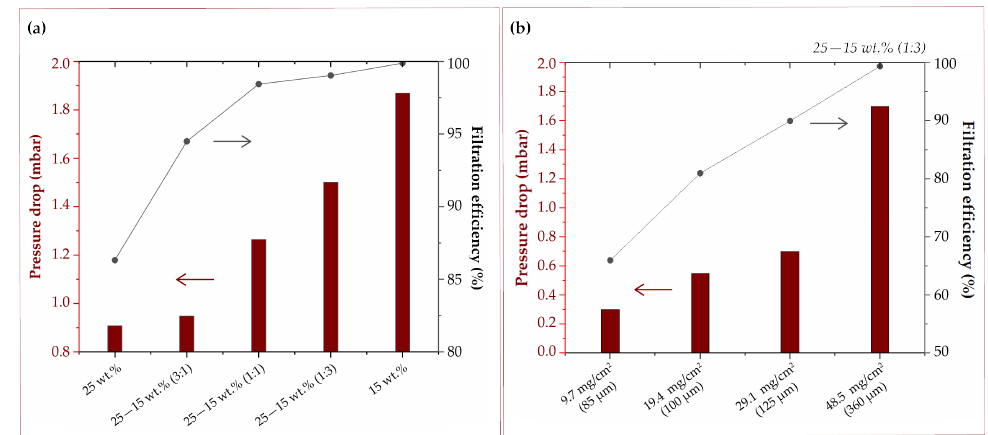
Figure 6. ( a ) Filtering efficiency against submicronic particles (0.01–1.0 µ m) and pressure drop against different combinations of fiber diameters obtained by electrospinning solutions of 15 and 25 wt.% PET at different ratios and ( b ) solutions of 15–25 wt.% PET (3:1) at different fabric